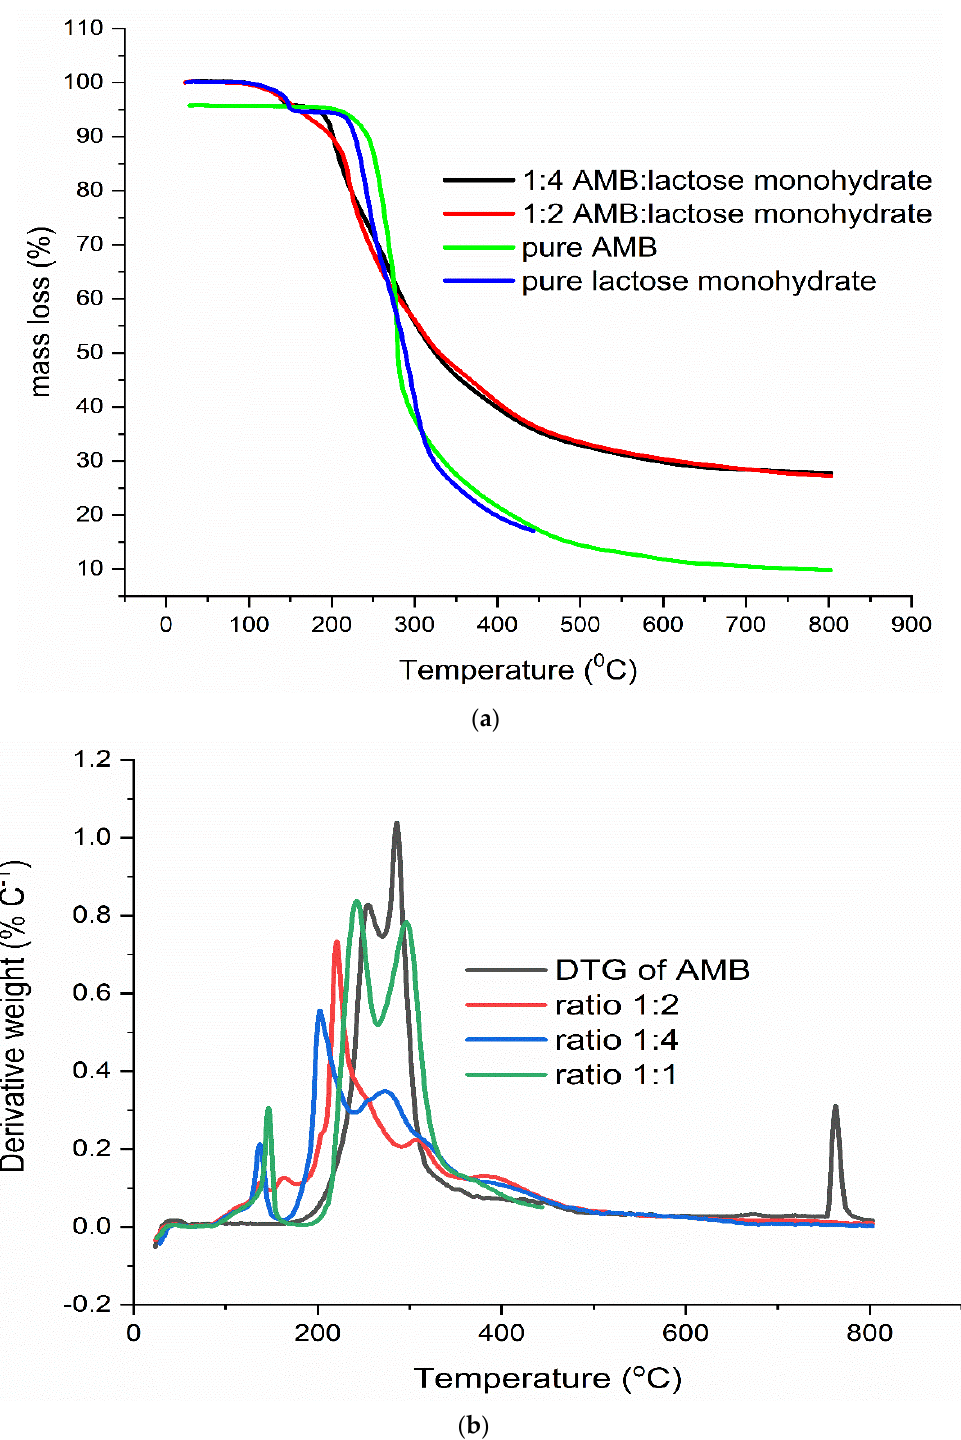
Figure A6. ( a,b ) TG/DTG curves of AMB/lactose monohydrate mixtures. Figure A6. ( a , b ) TG/DTG curves of AMB/lactose monohydrate